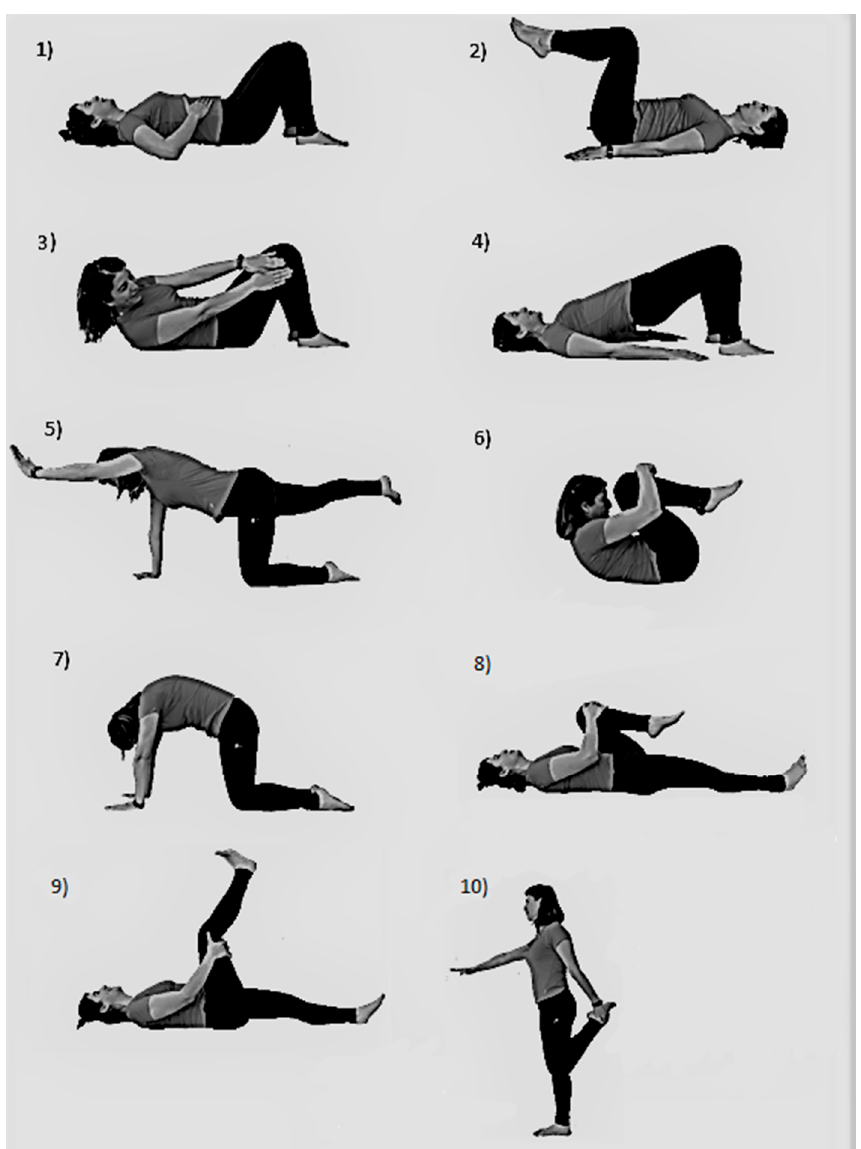
Figure 2. Back-School program exercises. ( 1 ) Abdominal hollowing; ( 2 ) Knee-up; ( 3 ) Oblique crunch; ( 4 ) Supine plank; ( 5 ) Bird-dog; ( 6 ) Knees-to-chest stretching; ( 7 ) Cat-camel; ( 8 ) Lying psoas stretching; ( 9 ) Lying hamstring stretching; ( 10 ) Standing quadriceps stretching.